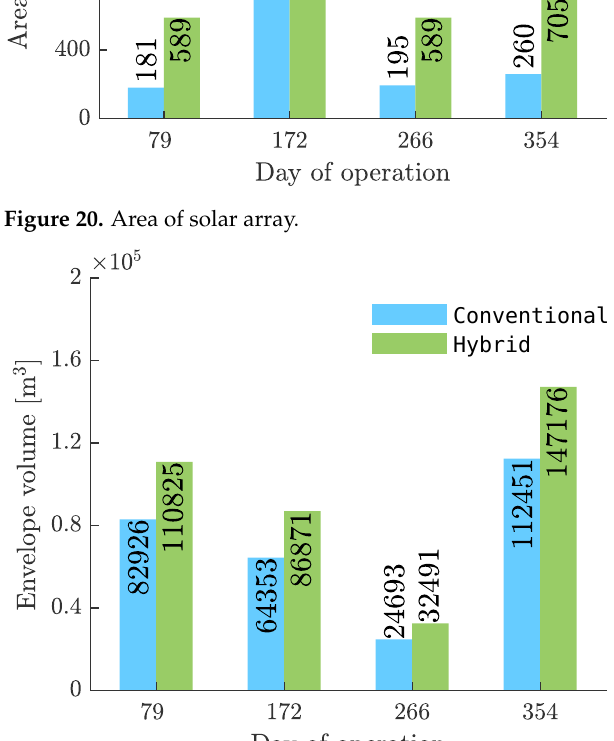
Figure 21. Envelope